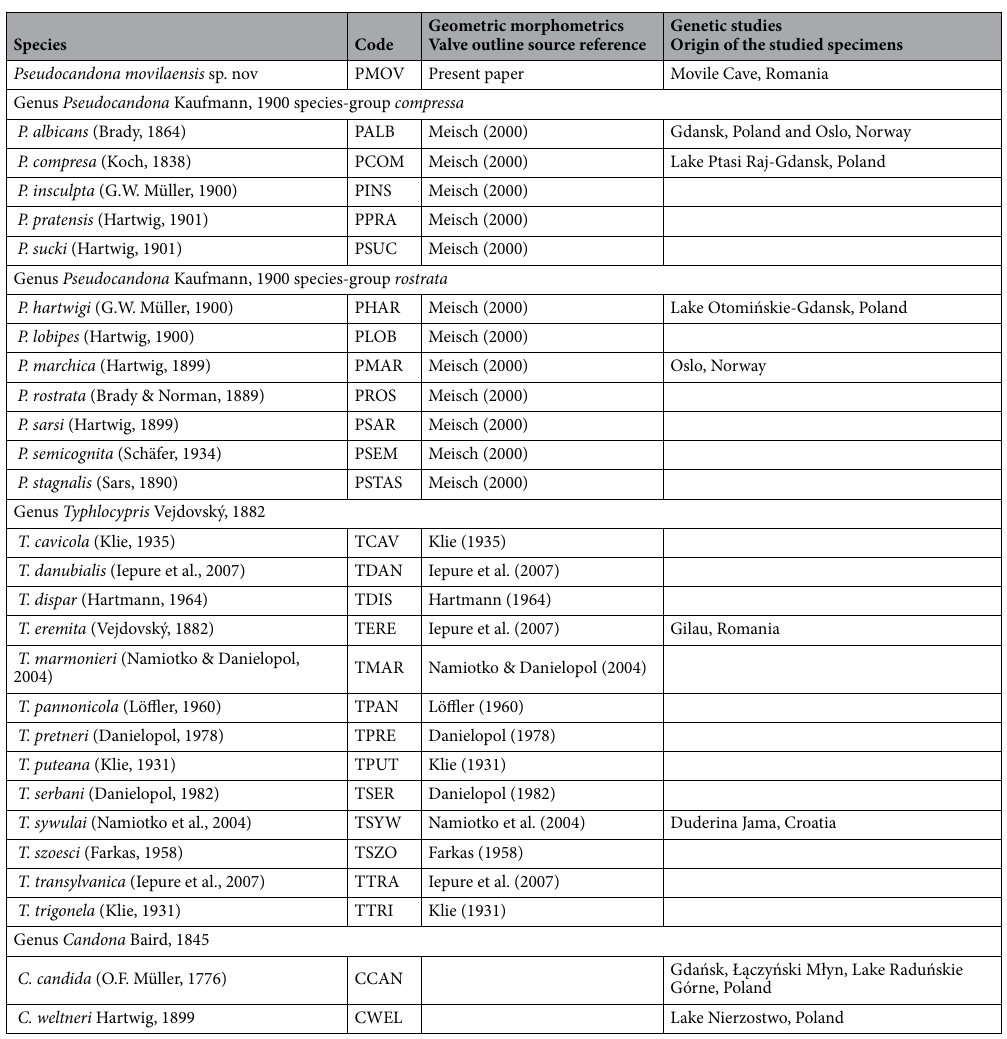
Table 1. Species used in genetic and geometric morphometry analyses with information on the origin of data used (with valve outline source references and sample localities). For the number of haplotypes and GenBank Accession numbers of the obtained COI sequences see Table